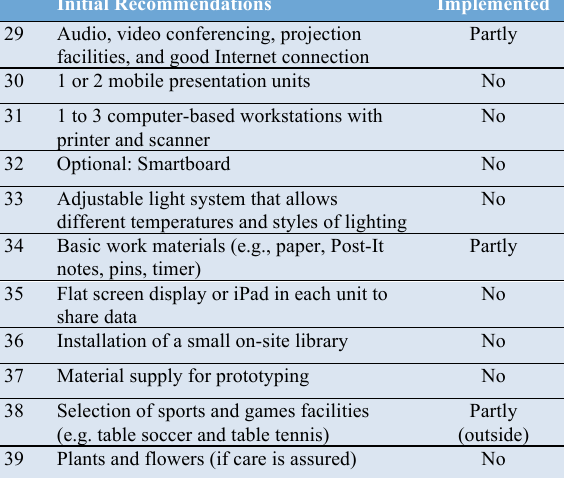
Selection of sports and games facilities (e.g. table soccer and table tennis)